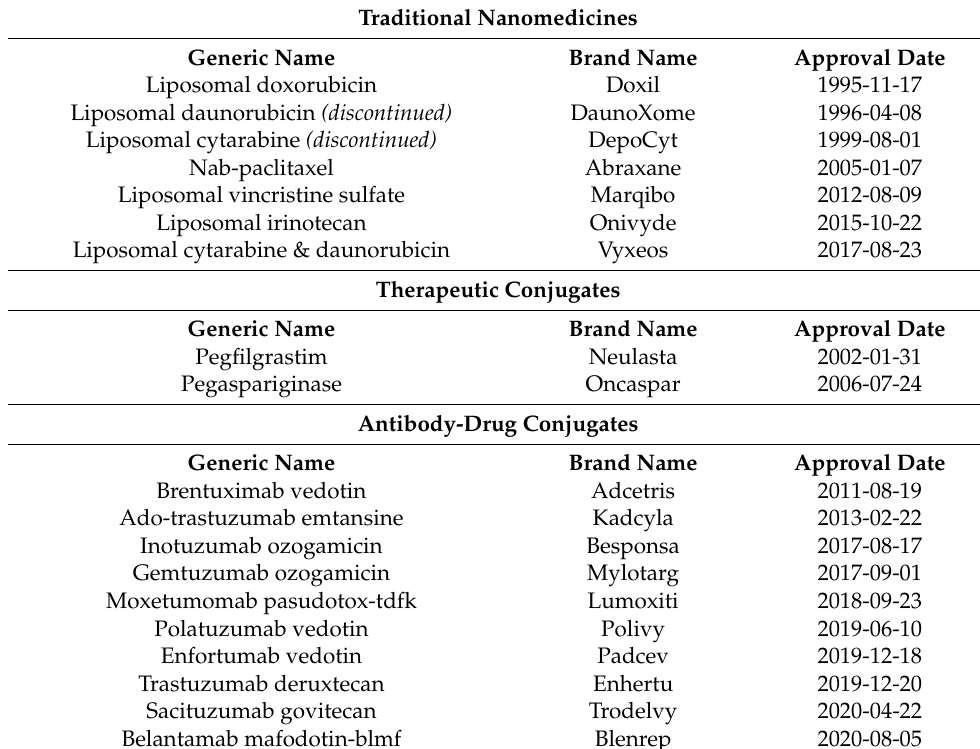
Table 1. Summary of FDA-approved carrier-mediated agents (including nanomedicines) with oncology indications for therapeutic use.